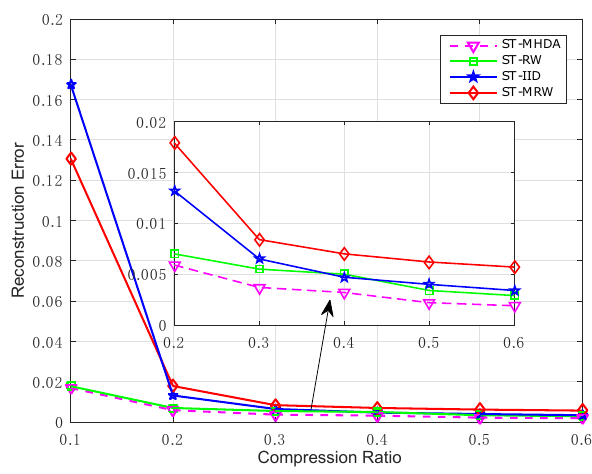
Figure 11. A comparison of the reconstruction error for different CS-based schemes under packet